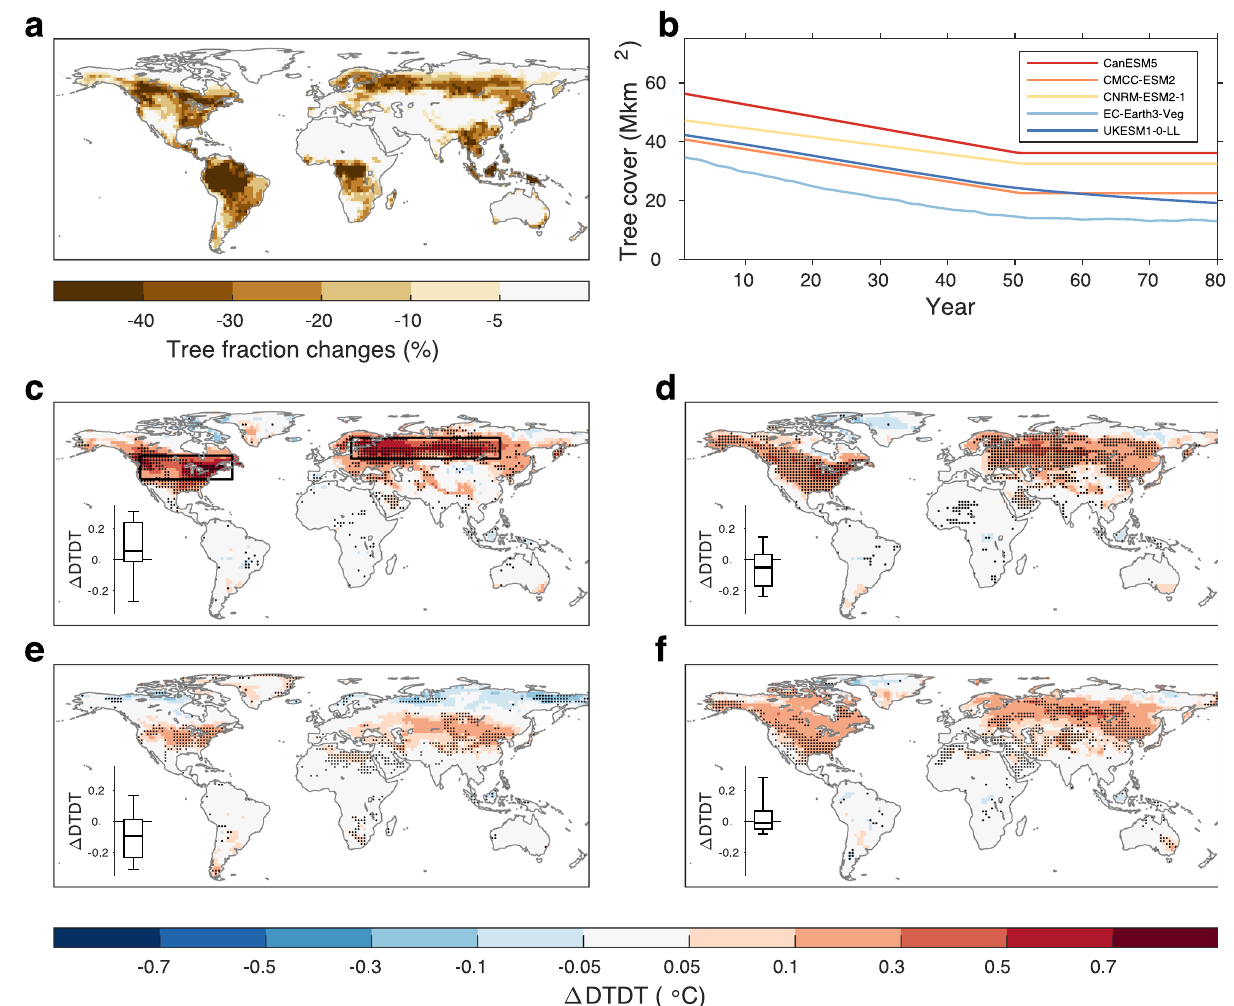
fi ve models agree on the sign of the DTDT change. The black rectangles in c cover the two regions in North America (38 – 54°N, 60 – 122°W) and Eurasia (52 – 66°N, 20 – 120°E), which are further analyzed in Fig. 2. The box-and-whisker plots embedded in c – f show the DTDT differences between the paired forest and openland sites (openland minus forest; Supplementary Fig. 5) from the FLUXNET and AmeriFlux datasets. The horizontal black line of the box denotes the median. The bottom and top edges of the box denote the 25th and 75th percentiles, respectively. The whiskers extend to the 10th and 90th